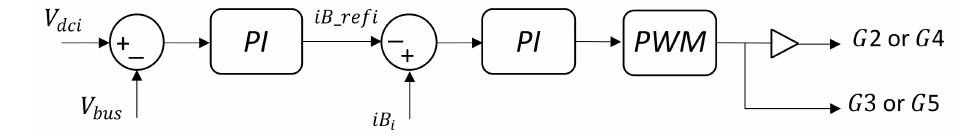
Figure 6. Bidirectional DC-DC control diagram